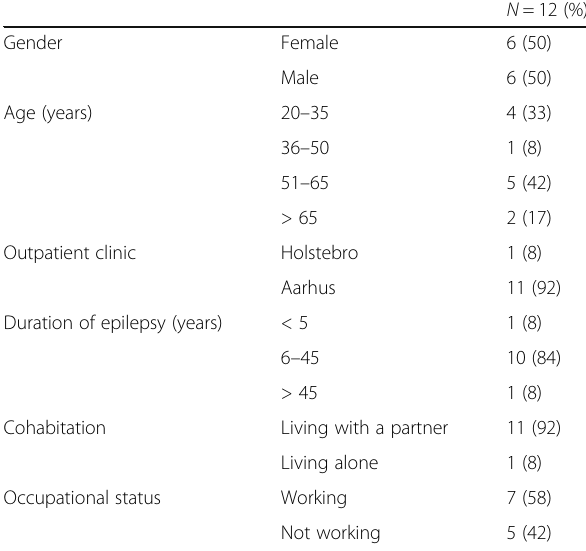
Table 2 Patient participant profile, individual interviews